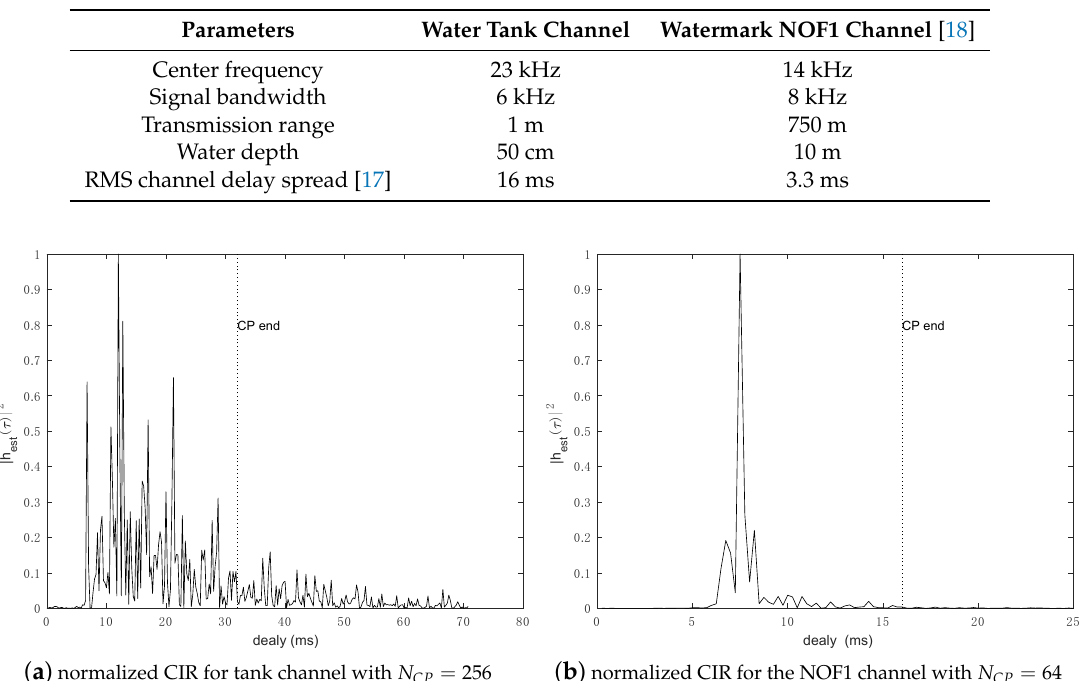
Figure 4. Channel impulse response for tank and NOF1 channels, the cyclic prefix tolerance as the dotted